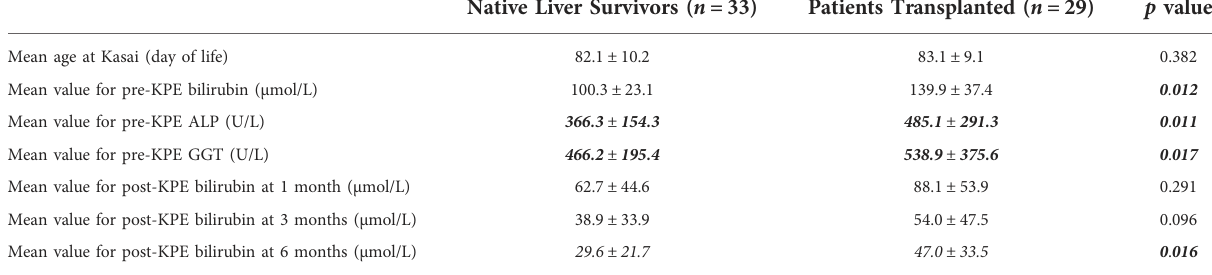
TABLE 1 Comparison of peri-operative liver function between native liver survivors and transplanted patients who underwent KPE after day 70 of life. Native Liver Survivors ( n = 33)